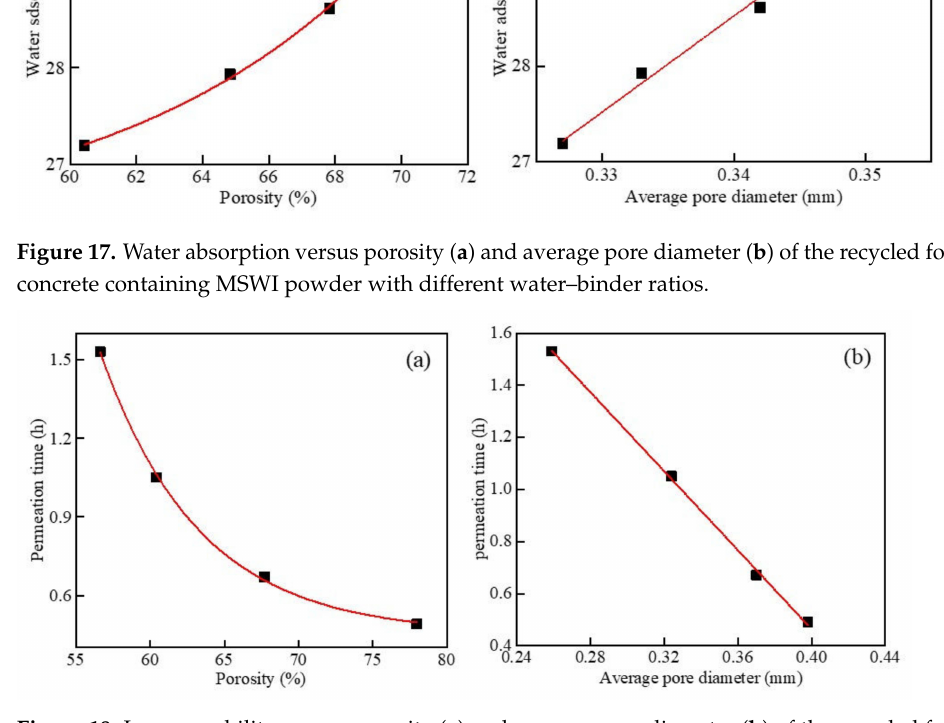
Figure 18. Impermeability versus porosity ( a ) and average pore diameter ( b ) of the recycled foamed concrete containing MSWI powder with different dry